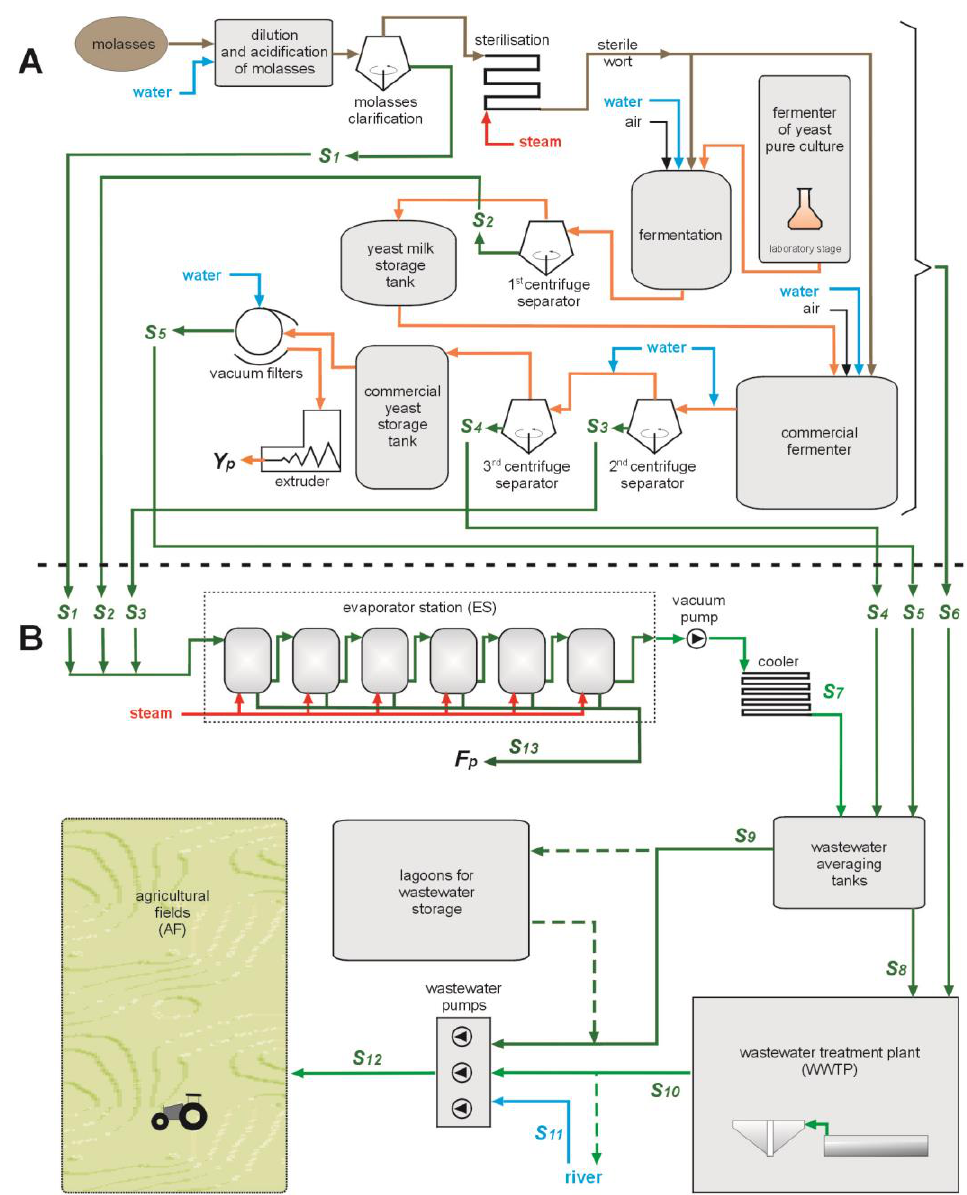
Figure 1. Scheme of the wastewater sources ( A ) and the three-stage wastewater treatment system ( B ) in the analyzed yeast factory. Y p , yeast production; F p , fertilizer production.